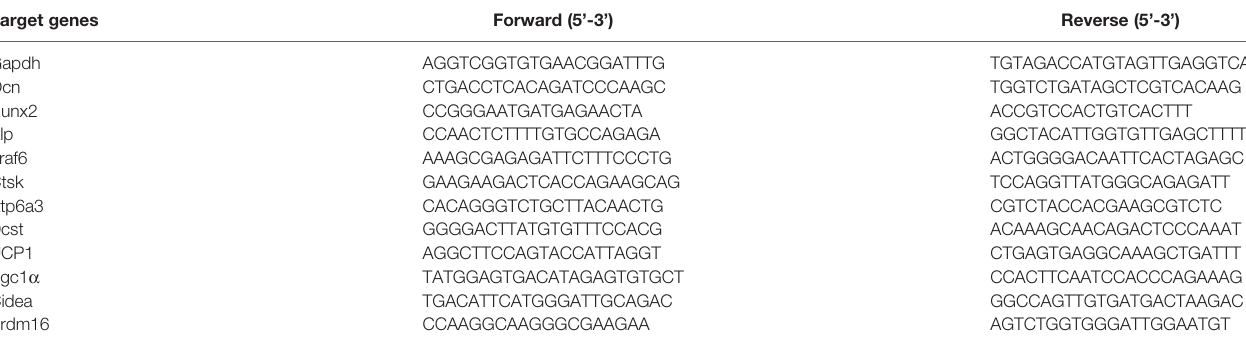
TABLE 1 | Primer sequences for the quantitative reverse ‐ transcription polymerase chain reaction.